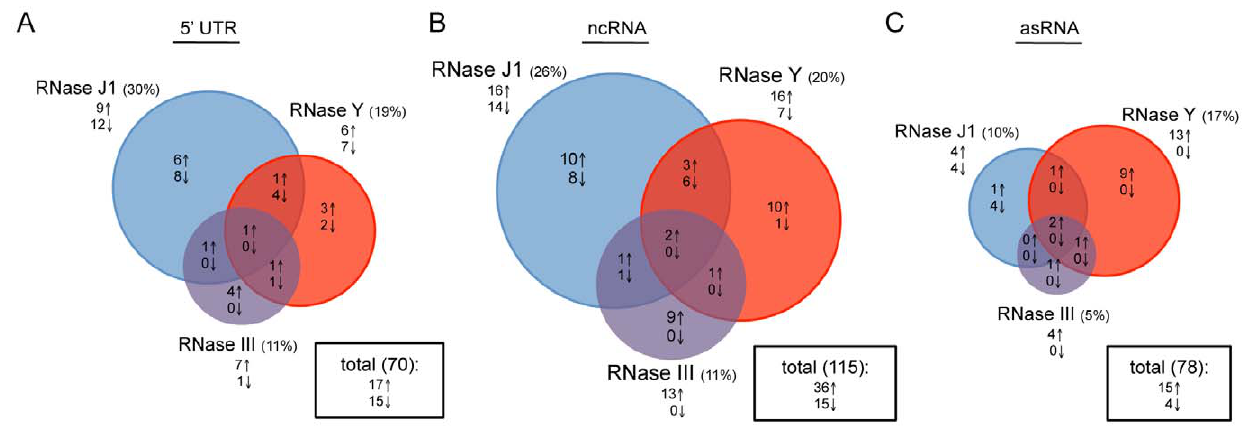
Figure 3. Effects of RNase J1, Y, and III depletion on abundance of B.subtilis regulatory RNAs. The Venn diagrams show the number of (A) 5 9 -UTRs, (B) potential ncRNAs and (C) potential asRNAs altered in each of the three mutant strains CCB034 (RNase J1), CCB294 (RNase Y) and CCB288 (RNase III). Upward pointing arrows indicate the number of RNAs showing increased abundance; downward pointing arrows indicate decreased abundance. The areas of the circles are proportional to the number of RNAs showing altered abundance in each strain. The total number of RNAs affected in the experiment is shown in the rectangle to the right of each Venn diagram.